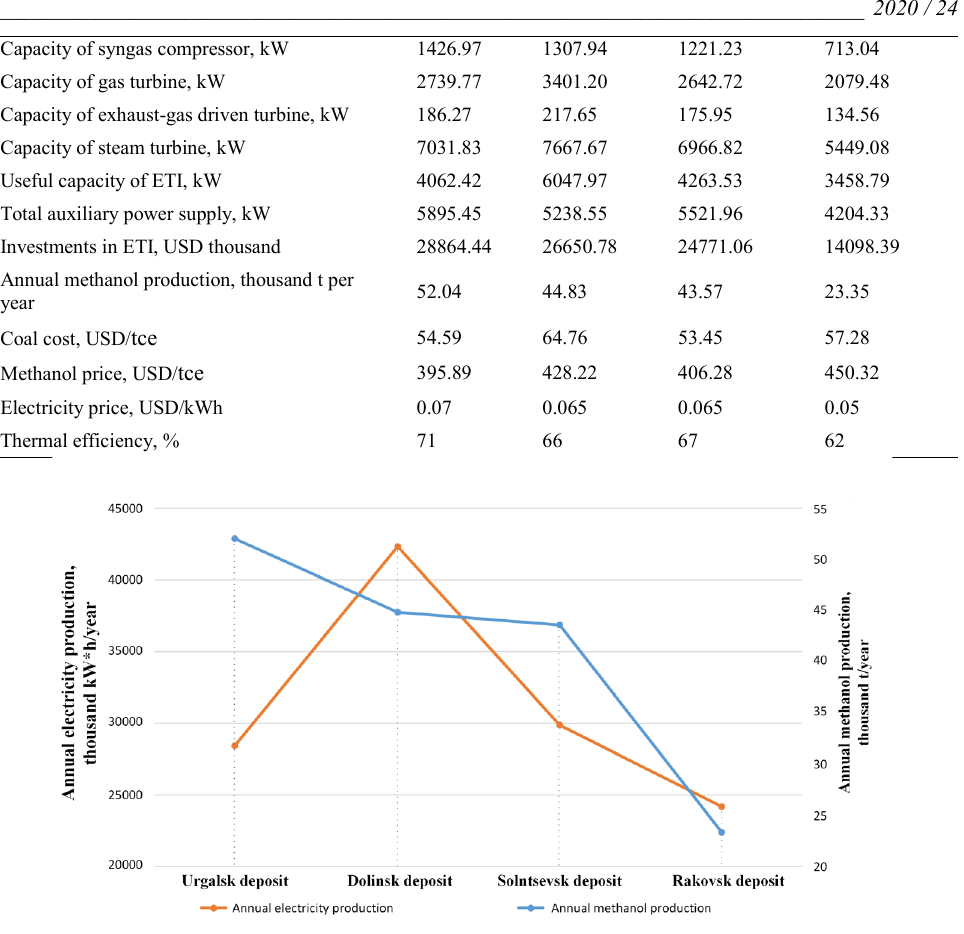
Fig. 3. Annual production of methanol and electricity for each optimal ETI